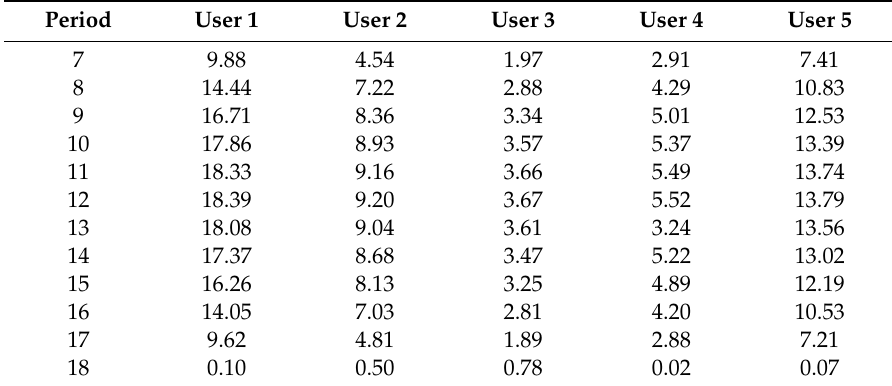
Table 9. PV output power (kW · h).